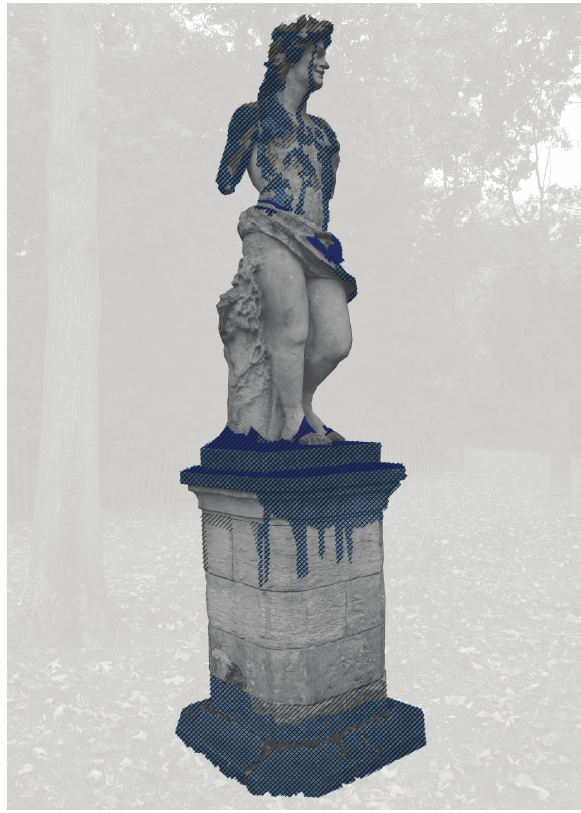
Figure 7. Evolution of Alga between 1999 and